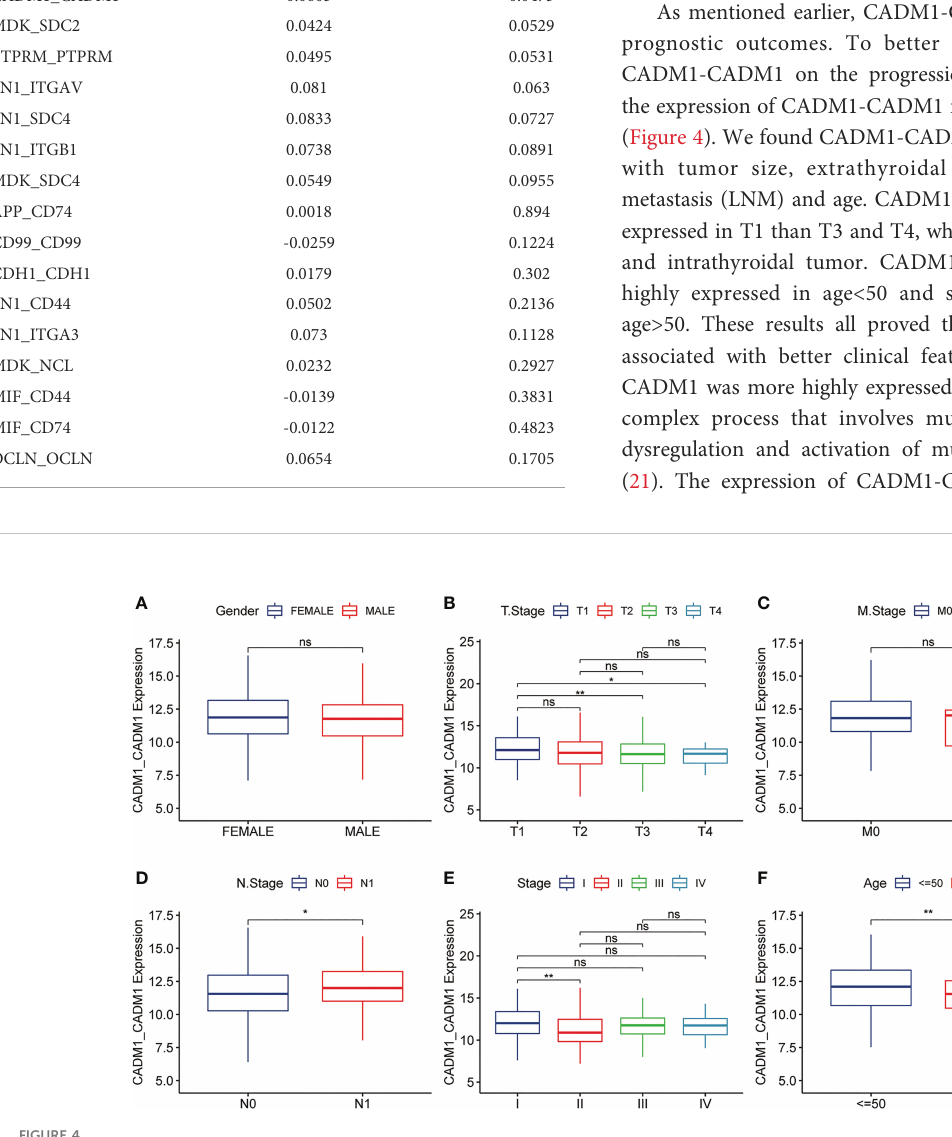
FIGURE 4 Differences in the expression of CADM1-CADM1 in clinical phenotypes (** P < 0.01, *P < 0.05). The differences in CADM1-CADM1 by gender (A) , T stage (B) , M stage (C) , N stage (D) , stage (E) and age (F) . ns, no signi fi cance.